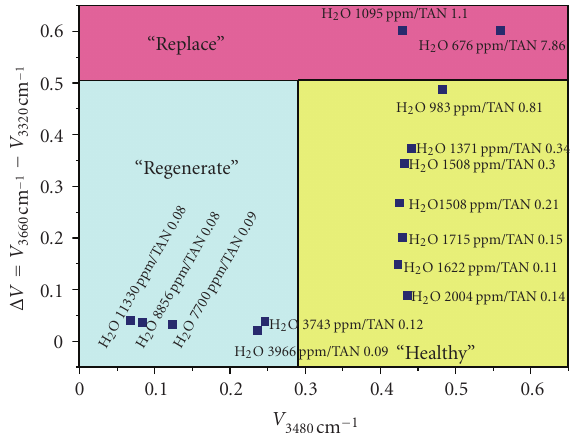
Figure 13: “Health plot” of pure and degraded hydraulic fluids as determined by the NDIR sensor system demonstrator. This is based on the authorized in-service limits (by Airbus), for water and